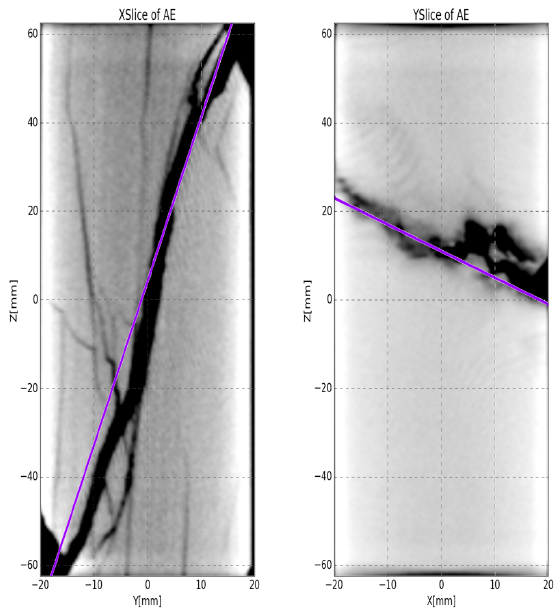
Figure 19. This figure is the X and Y axis CT scan images and fracture plane identification result overlap display.